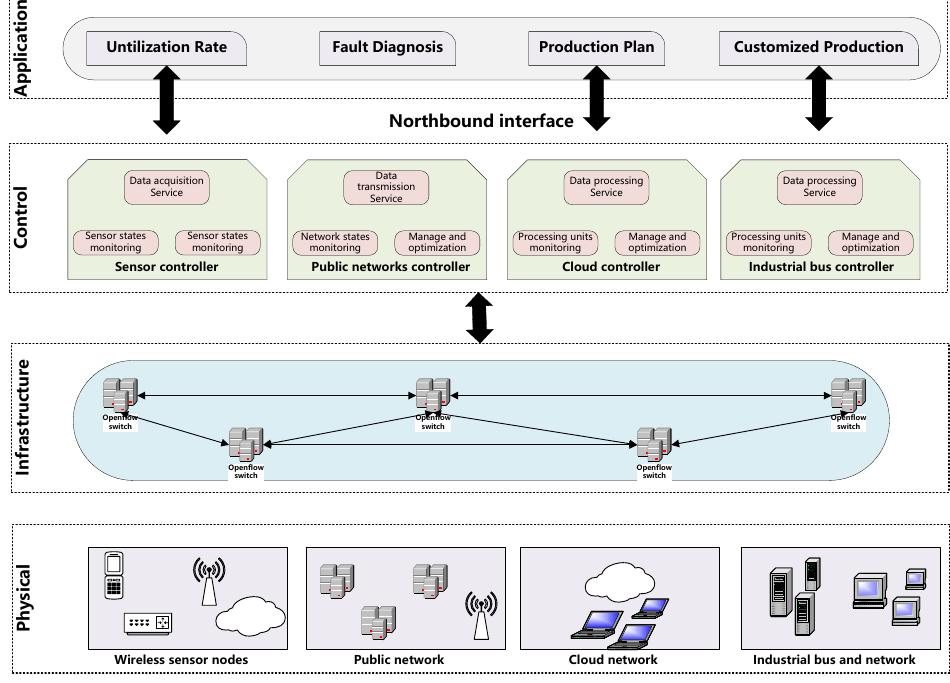
Figure 1. SDN network architecture